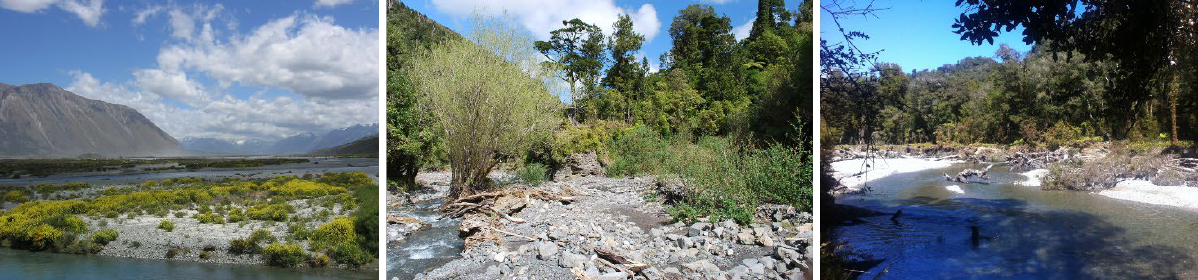
Figure 1. Invasion of exotic vegetation in Aotearoa’s wild rivers—left: lupin, Rakaia River, foothills Southern Alps; middle: willow and buddleia, Tamaki River, headwaters Ruahine Ranges; contrasted with right: intact native forest in lower reaches of Smoothwater River, West Coast South Island. (Images by Ian Fuller).